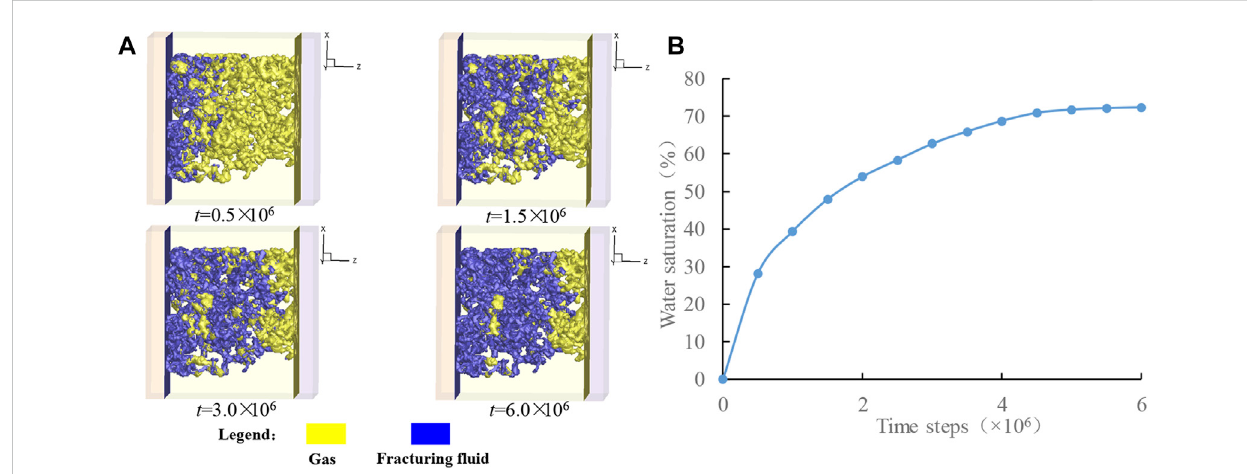
FIGURE 5 The gas-liquid distribution in shale at different time steps (A) and the water saturation versus time steps (B) in the imbibition process.